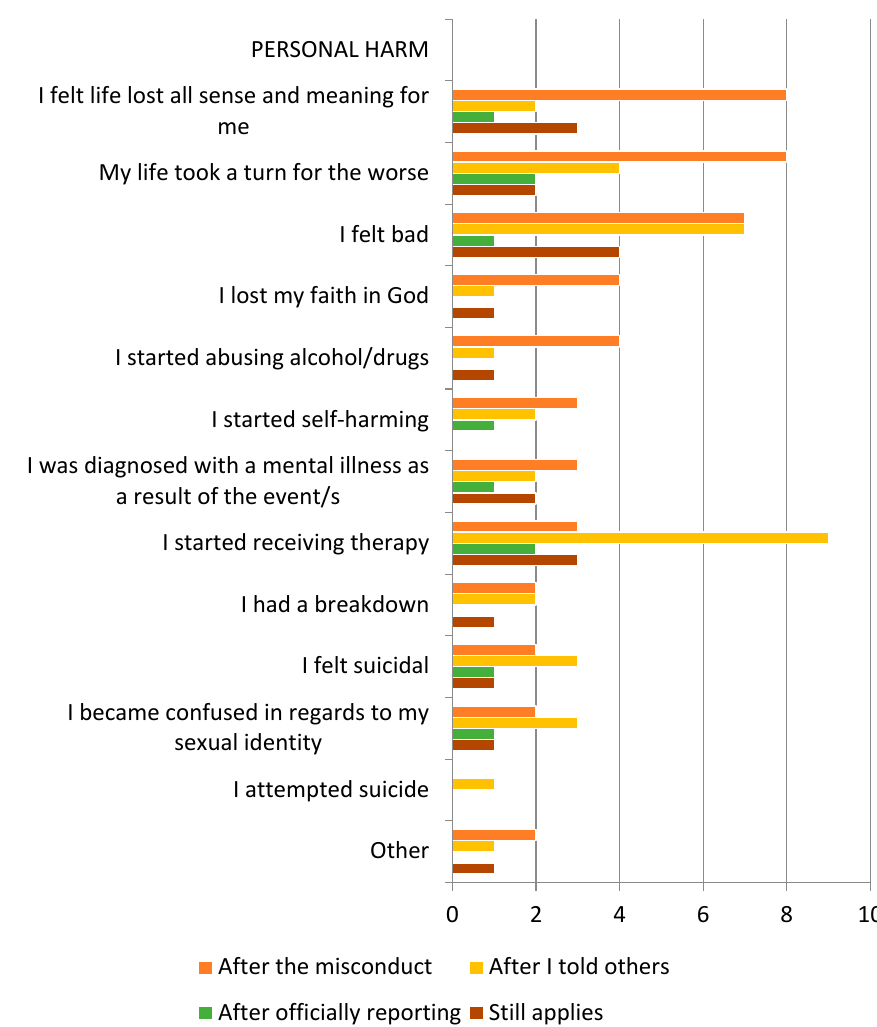
Figure 3. Personal harm produced by CSMAA according to periods of time ( n = 22). More than one response was permitted.